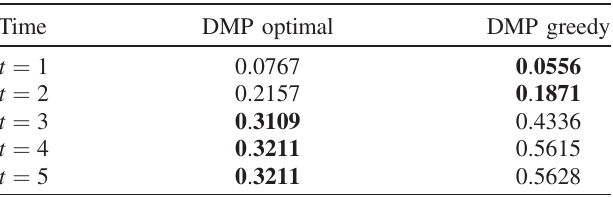
P P i T Þ =N . i B ð